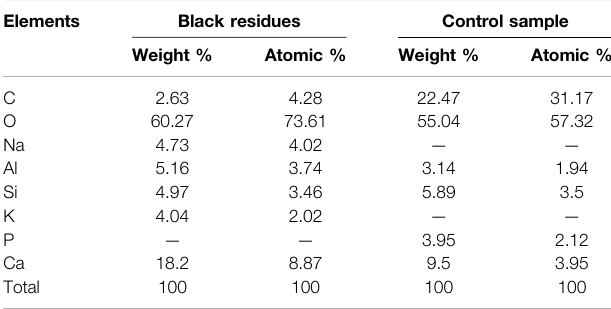
Elements Black residues